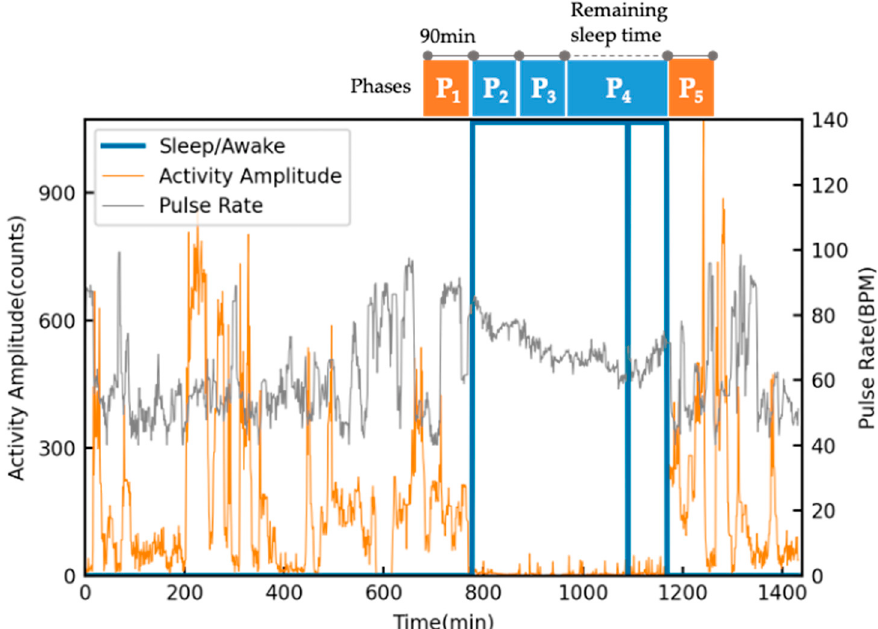
Figure 3. The five phases for heart rate variability analysis in the proposed method.